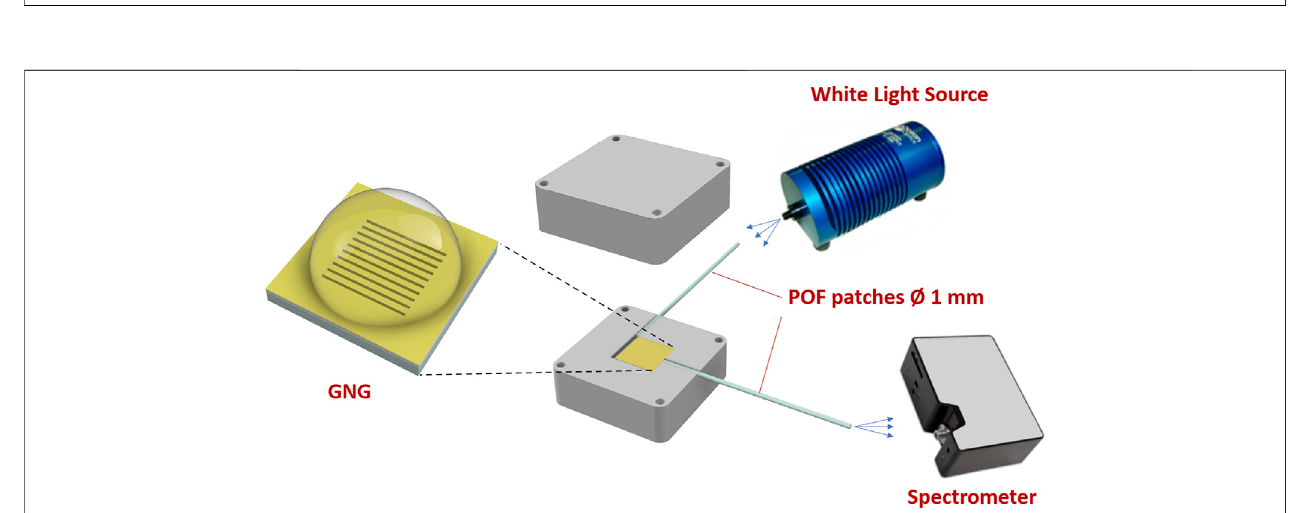
FIGURE 3 | Nanoplasmonic bio/sensor chip ’ s experimental